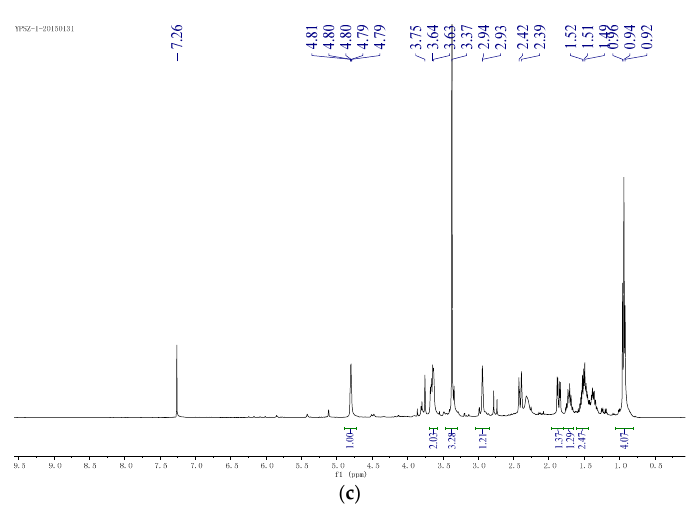
Figure 4. Absolute configuration of compound 1 . ( a ) CD spectrum of compound 3 in MeOH; ( b ) 1 H-NMR spectrum of compound 1 in C 5 D 5 N; ( c ) 1 H-NMR spectrum of compound 1 in CDCl 3 . Compound 2 , yellow oil ([ α ] 25 +82.0 ( c 1.30, MEOH)), had the molecular formula of C 11 H 18 O 5 , as D established by HRESIMS ion at m/z 253.1053 [M + Na] + (cald. 253.1052) and 13 C-NMR data. The IR spectrum exhibited absorption bands for hydroxyl groups (3416 cm − 1 ) and carbonyl groups (1746 and 1699 cm − 1 ). The 1 H-NMR spectra exhibited signals for one methyl groups (H 0.89, 3H, t, J = 7.2 Hz), one oxymethyl (H 3.76, 3H, s), and a series of aliphatic methylene or methine multiplets (Table 1). The